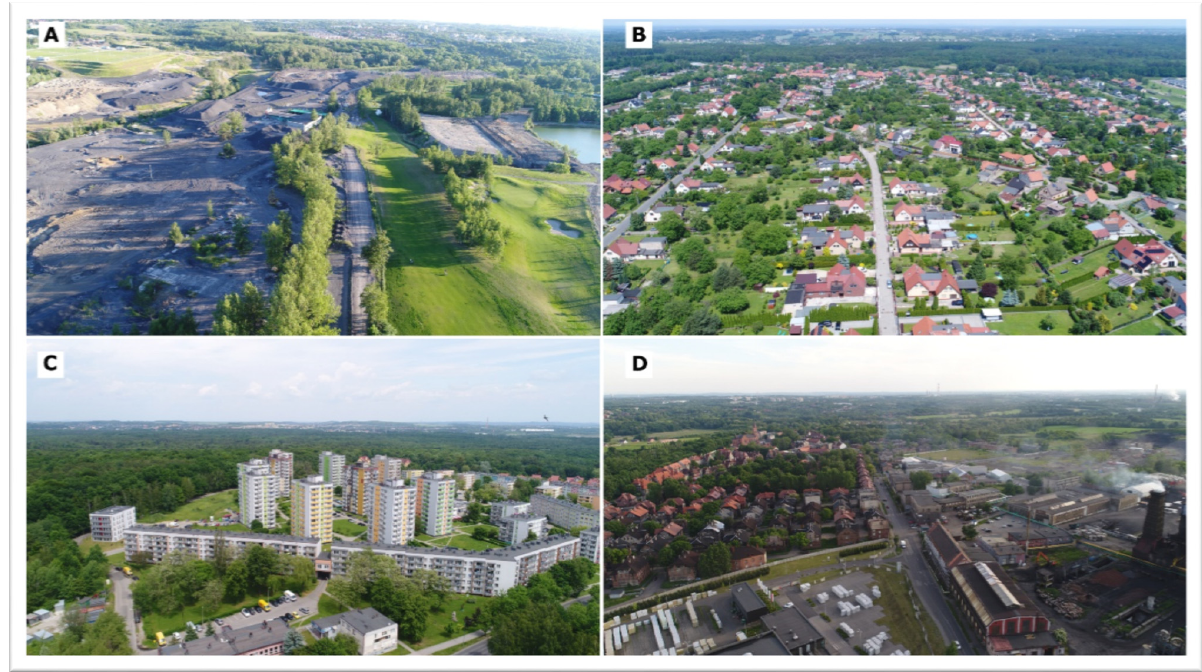
Figure 7. Selected landscapes of Bytom in 2021 (Sourced by authors). Explanations: ( A )—Reclaimed areas of the former Szombierki Coal Mine; ( B )—Single-family housing in the agricultural district of the Stolarzowice; ( C )—Housing estate in the Miechowice district; ( D )—The workers’ housing estate from the beginning of the 20th century (Nowa Kolonia Robotnicza) and a coking plant in the Bobrek district.